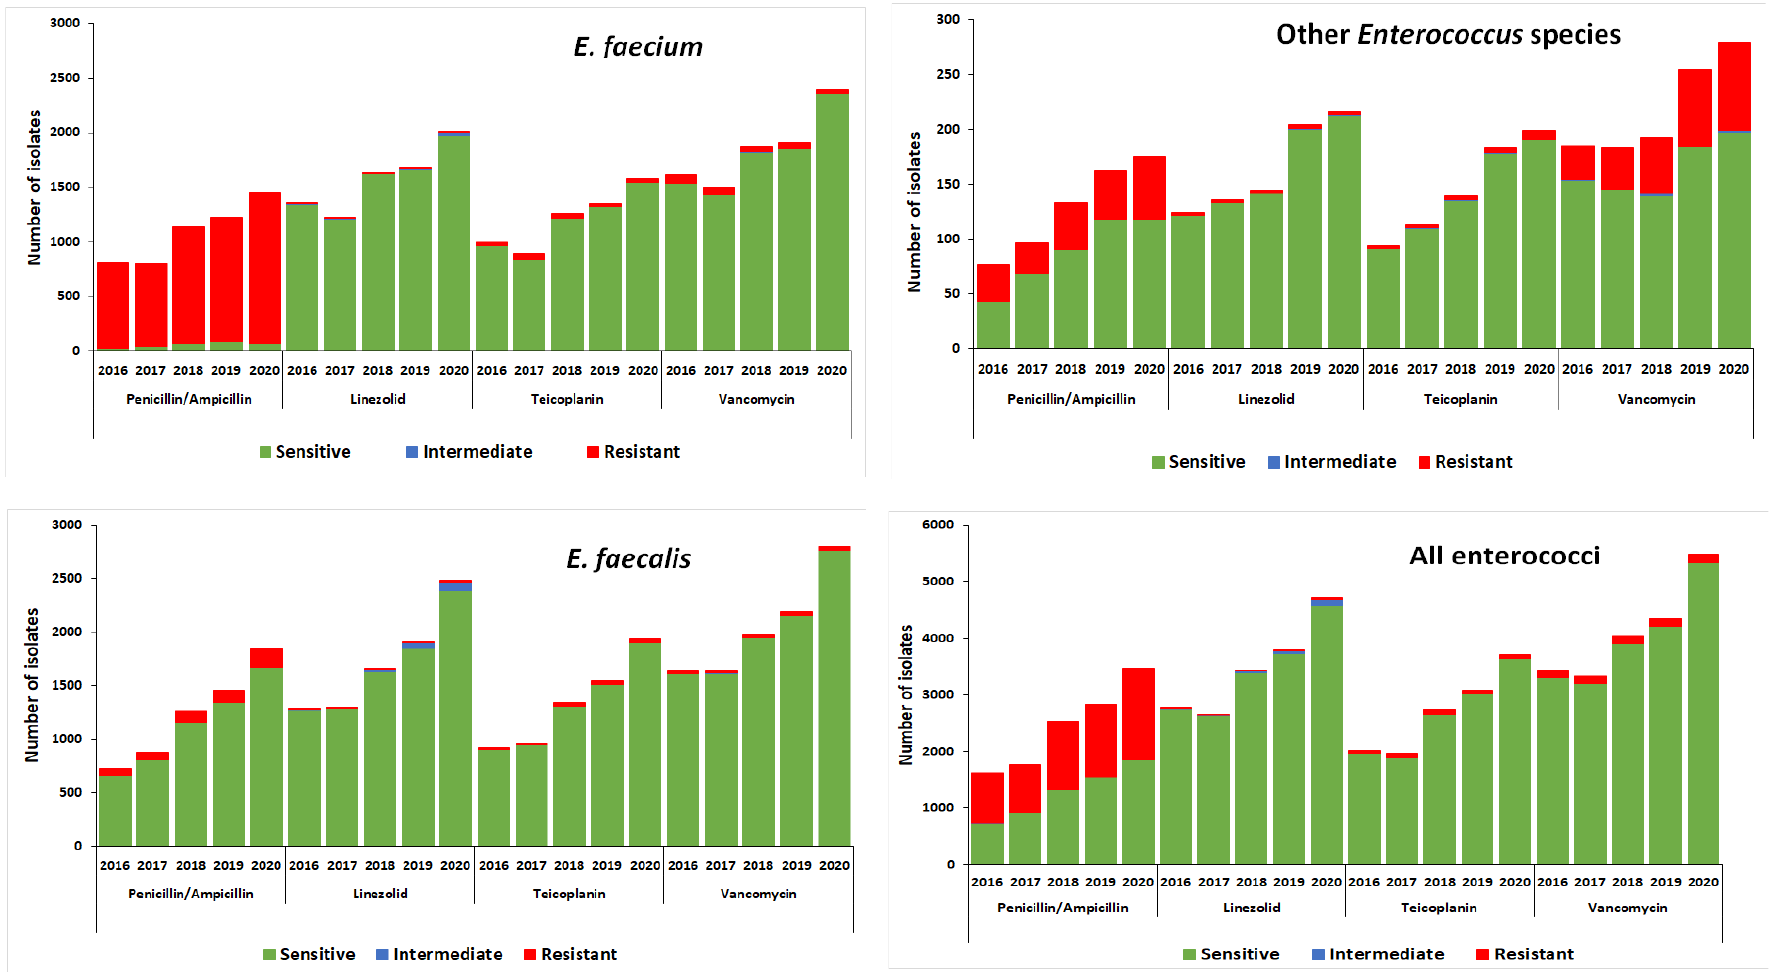
Figure 4. Antimicrobial susceptibility profiles for all Enterococcus species bloodstream infection isolates in South Africa, from 2016 to 2020 ( n = 21,339). Other enterococci included: E. avium , E. casselifalvus , E. cecorum , E. columbae , E. durans , E. gallinarum , E. hirae , E. raffinosus , other E. species ( n = 1185).